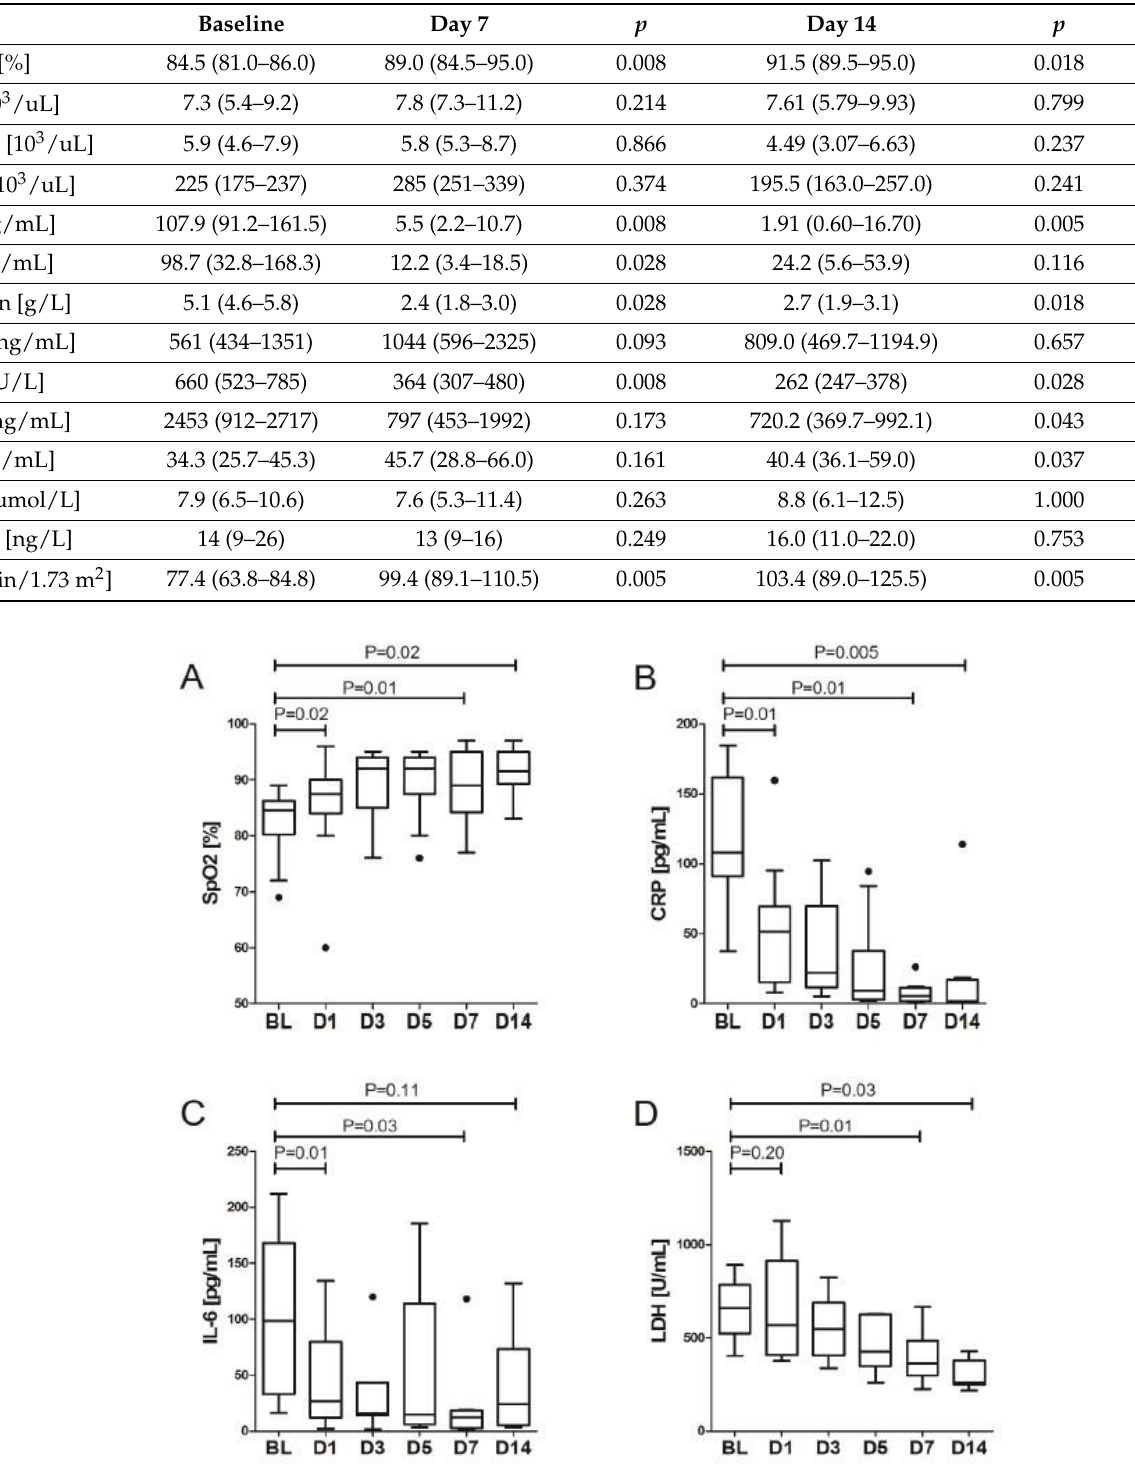
Figure 1. The change of concentration of selected parameters in the blood in subsequent days after LDRT. ( A ) O 2 saturation, ( B ) C-reactive protein, ( C ) interleukin 6, ( D ) lactate dehydrogenase. Bold dots denote outliers.